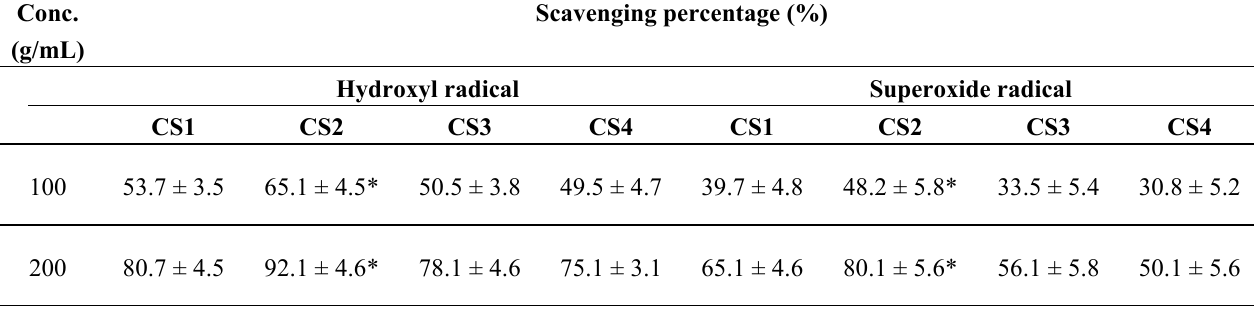
Table 2. Effect of LMW chitosans on the scavenging of different radical species, as assessed by ESR